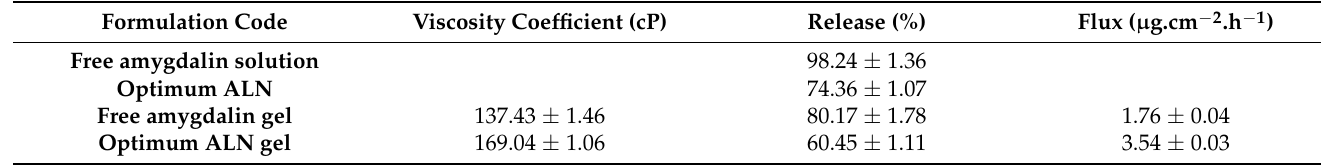
Table 3. In vitro characterization of optimum ALN gel formulation.